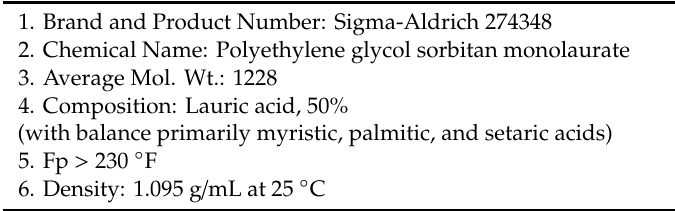
Table 3. Composition and properties of emulsifier used in small model factory (inflow parameters values are 1.5 mg / L, 3.0 mg / L, 6.0 mg / L, and 12.0 mg / L).